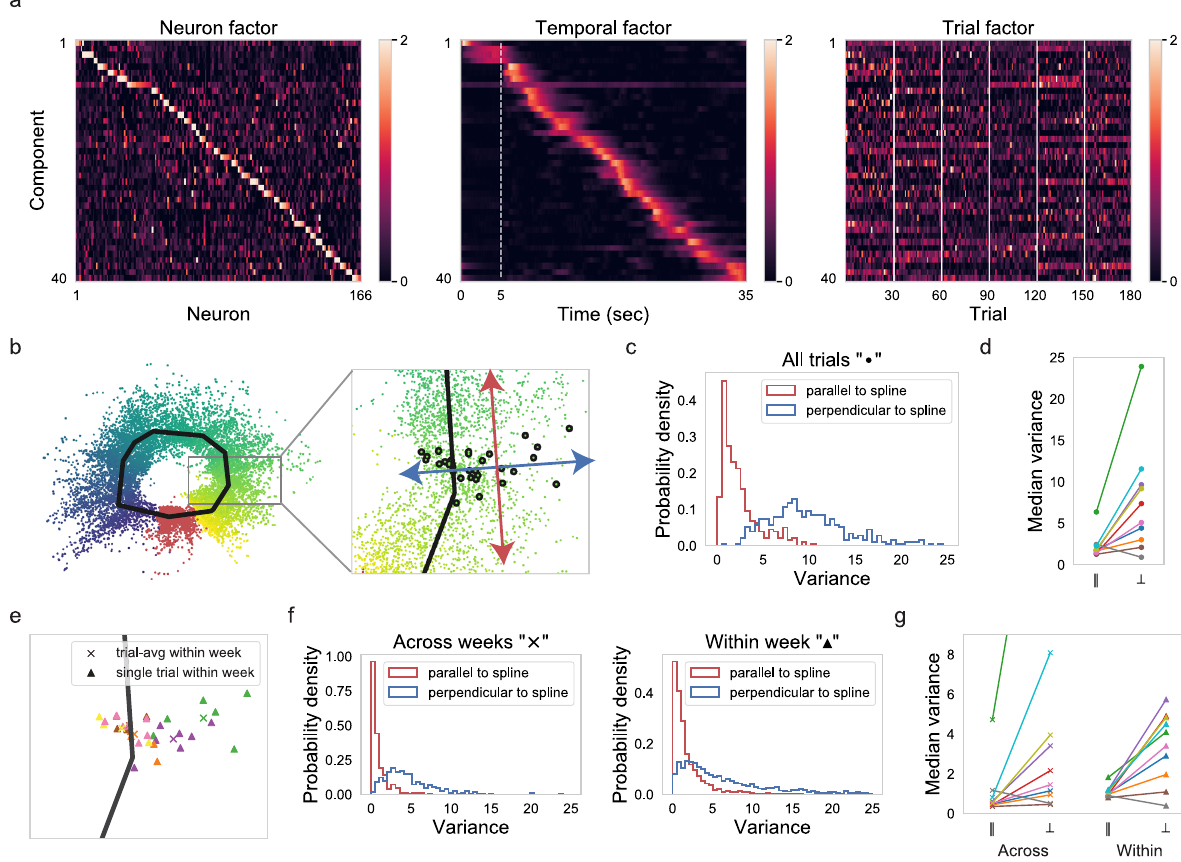
Fig. 6 Both week-to-week fl uctuation and trial-to-trial variation within the week is restricted to non-coding directions. a TCA components of one imaging fi eld ( n = 166). We ordered components by the time to peak in their temporal factors. We ordered neurons in the neuron factors by their dominant components. Colormap maximum values are set to 2 for all the factors. b Left: two-dimensional neural manifold extracted from reconstructed (denoised) Δ F / F population activity ( n = 166) across weeks using Isomap. Each dot represents instantaneous population activity in the test set. The color of the dot (same colormap as Fig. 4a) indicates the corresponding time in the trial. The black line is the fi tted spline to the training set. Right: zoom-in view on the neural manifold. Instantaneous population activity corresponding to 28 s in the trial was highlighted with black shade. The Blue arrow denotes the direction perpendicular to the spline, and the red arrow denotes the direction parallel to the spline. c Histogram of the variance of population activity parallel or perpendicular to the spline for the imaging fi eld shown in ( a , b ). d Median variance of population activity parallel to the spline plotted against median variance of population activity perpendicular to the spline for all the imaging fi elds. The variance of population activity parallel to the spline was signi fi cantly smaller than the variance perpendicular to the spline for most imaging fi elds (one-sided Wilcoxon signed-rank test, 350 timepoints, p -values for different imaging fi elds are 3.93 × 10 − 31 ( n = 63), 2.61 × 10 − 55 ( n = 84), 1.78 × 10 − 40 ( n = 140), 2.61 × 10 − 58 ( n = 150), 2.91 × 10 − 59 ( n = 166), 7.37 × 10 − 57 ( n = 185), 2.06 × 10 − 59 ( n = 293), 3.03 × 10 − 31 ( n = 353)), except for two imaging fi elds ( p = 1.0 (gray, n = 49) and p = 0.997 (brown, n = 88)). The two outliers are from two imaging fi elds whose neural manifold didn ’ t have a clear ring shape (Supplementary Fig. 5a). e The same zoom-in view on the neural manifold as shown in ( b ) (right). Each triangle represents instantaneous population activity within a week. The color of the triangle denotes different weeks. Each cross represents the trial-averaged instantaneous population activity within a week. The color of the cross also denotes different weeks. f Left: histogram of the variance of trial-averaged population activity within a week parallel or perpendicular to the spline for the imaging fi eld. Right: histogram of the variance of single-trial population activity within a week parallel or perpendicular to the spline for the imaging fi eld. g Median variance of trial-averaged population activity or single-trial population within a week parallel to the spline plotted against median variance of population activity perpendicular to the spline for all the imaging fi elds. Y- axis is clipped at 9 for visualization. The variance of population activity parallel to the spline was signi fi cantly smaller than the variance perpendicular to the spline for both across weeks and within a week cases for most imaging fi elds (across weeks: one-sided Wilcoxon signed- rank test, 350 timepoints, p -values for different imaging fi elds are 1.45 × 10 − 27 ( n = 63), 1.41 × 10 − 39 ( n = 84), 1.55 × 10 − 33 ( n = 140), 5.13 × 10 − 57 ( n = 150), 8.50 × 10 − 58 ( n = 166), 1.29 × 10 − 54 ( n = 185), 1.26 × 10 − 57 ( n = 293), 1.25 × 10 − 29 ( n = 353), two outliers p = 1.0 (gray, n = 49), p = 0.99 (brown, n = 88); within a week: one-sided Wilcoxon signed-rank test, number of samples = 350 timepoints× number of weeks, p -values for different imaging fi elds are 7.36 × 10 − 97 ( n = 63), 1.04 × 10 − 219 ( n = 84), 1.53 × 10 − 177 ( n = 140), 6.13 × 10 − 171 ( n = 150), 6.23 × 10 − 273 ( n = 166), 0.0 ( n = 185), 0.0 ( n = 293), 2.99 × 10 − 120 ( n = 353), two outliers p = 1.0 (gray, n = 49), p = 1.0 (brown, n =